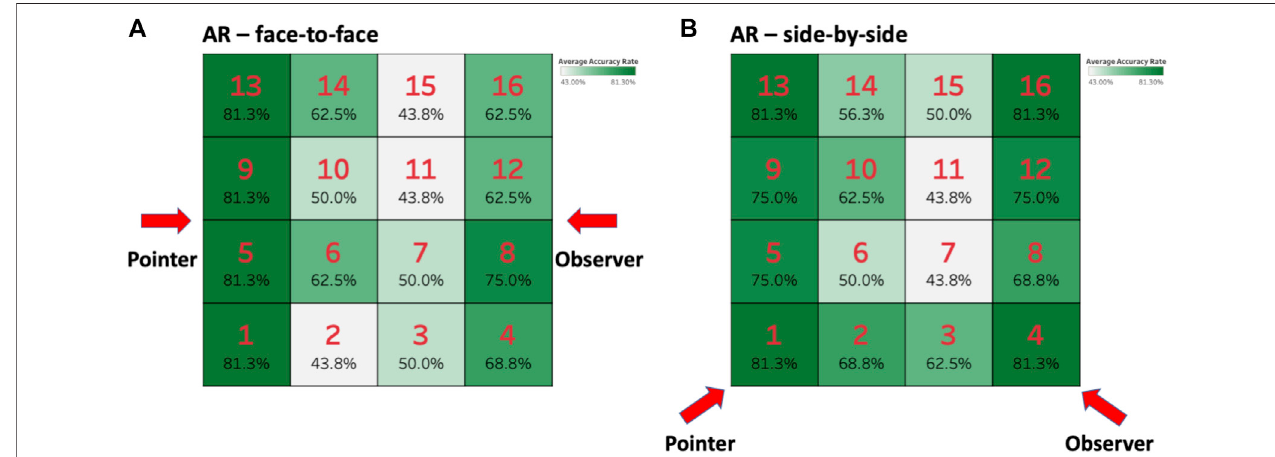
FIGURE 7 | Heatmaps of accuracy rate for the AR condition in two spatial con fi gurations. (A) Heatmap of accuracy rate in the AR/face-to-face condition and (B) heatmap of accuracy rate in the AR/side-by-side condition.